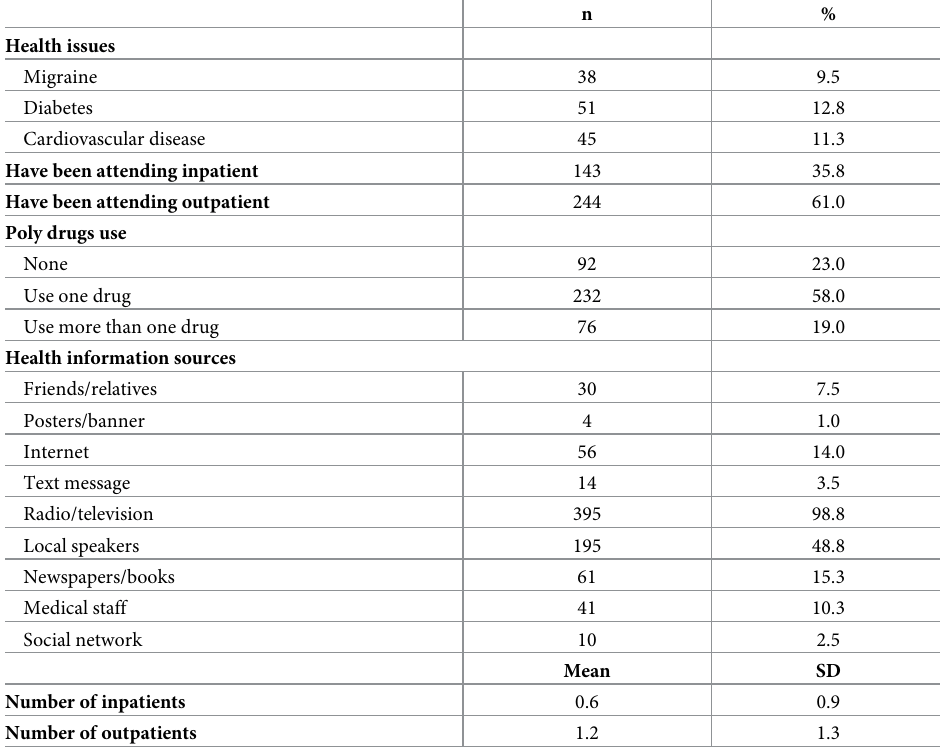
Table 2. Health status, HRQOL, health service utilization, and health information